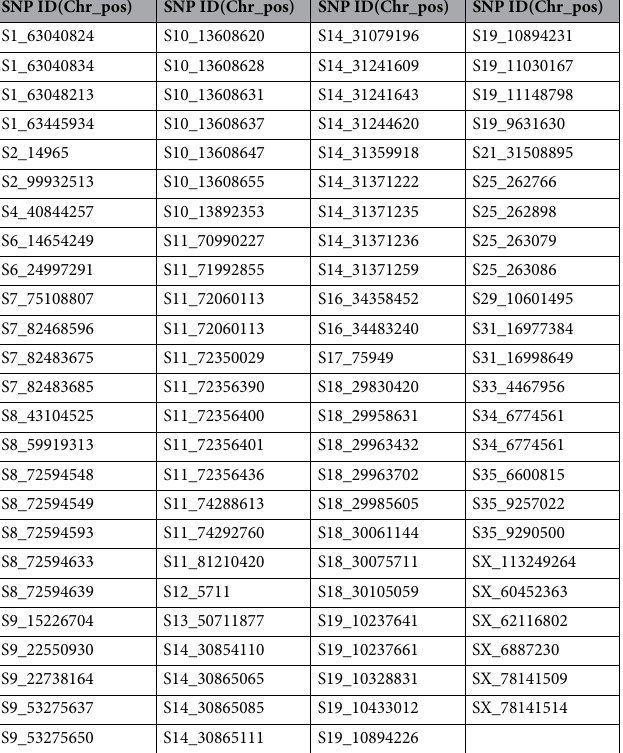
Table 5. List of SNP markers associated with camel growth at −Log p value ≥ 2.5.